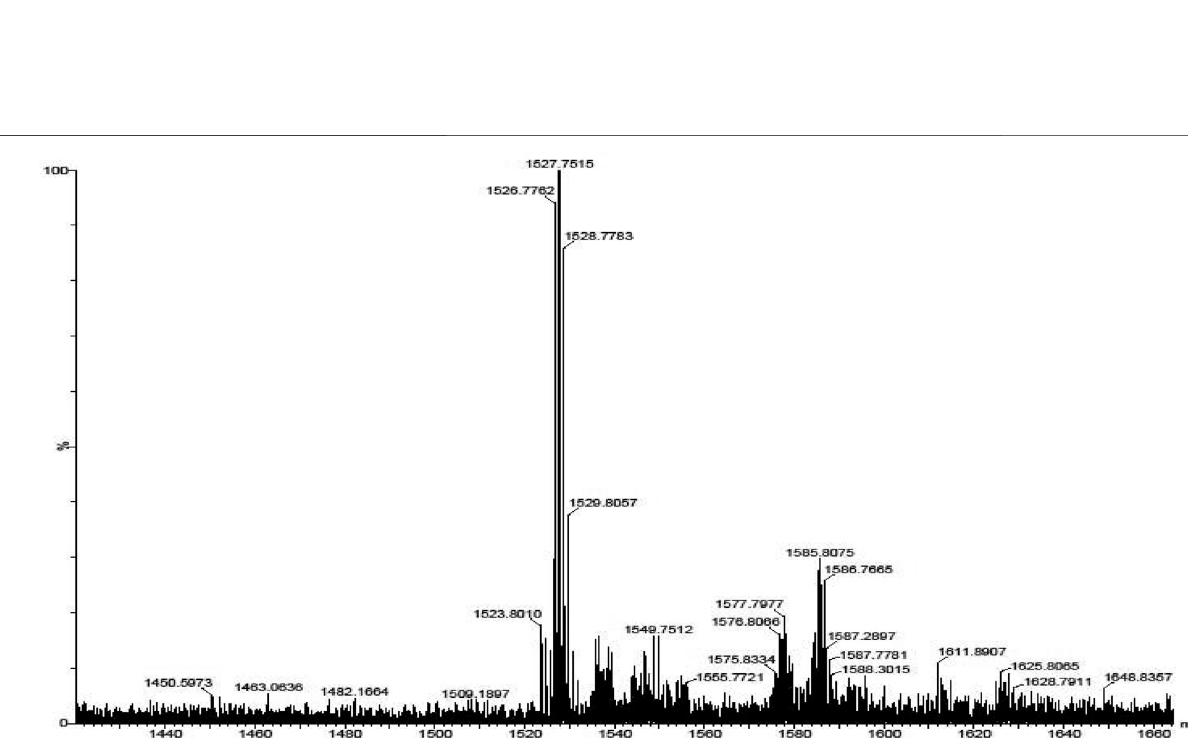
Frontiers in Chemistry |